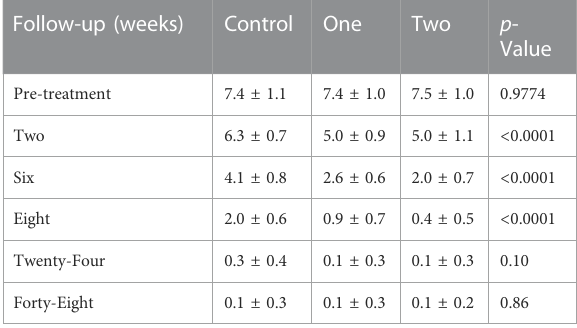
TABLE 2 Clinical results of the visual analogue scale (VAS) score a . Follow-up (weeks) and − 73% are related to the ATFL. The ATFL injury increases the likelihood of repeated sprains and anxiety during inversion stress. For all grades of LAS, conservative management and early functional rehabilitation remain